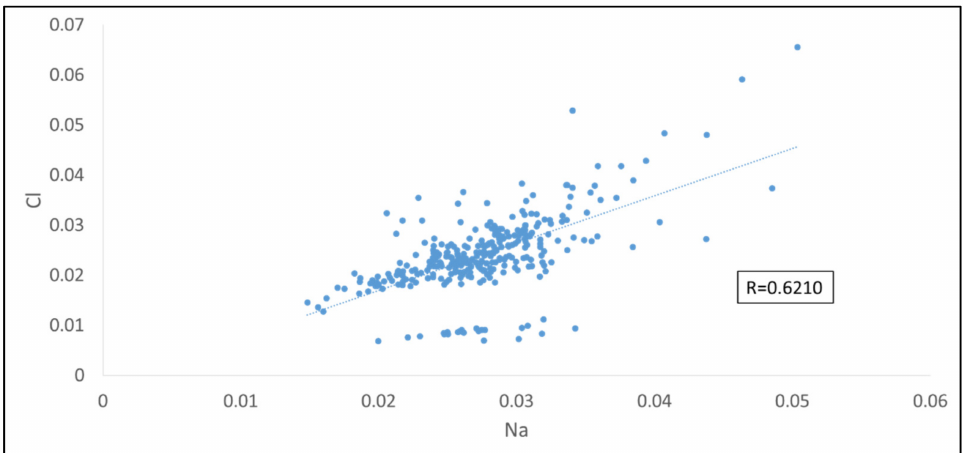
Figure 9. Relationship between the detected ions; Na + and Cl −